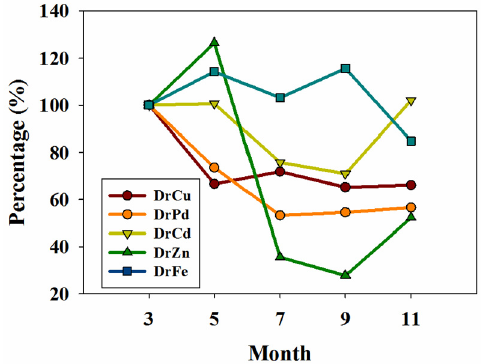
Figure 7. The concentration trends of dissolved reactive Cu, Pb, Cd, Zn, and Fe (DrCu, DrPb, DrCd, DrZn, DrFe) in Sishili Bay in 2018. Percentage values indicate the change in the metal concentrations in other months compared with the first months (where the first month’s concentration is set equal to 100%) [29].